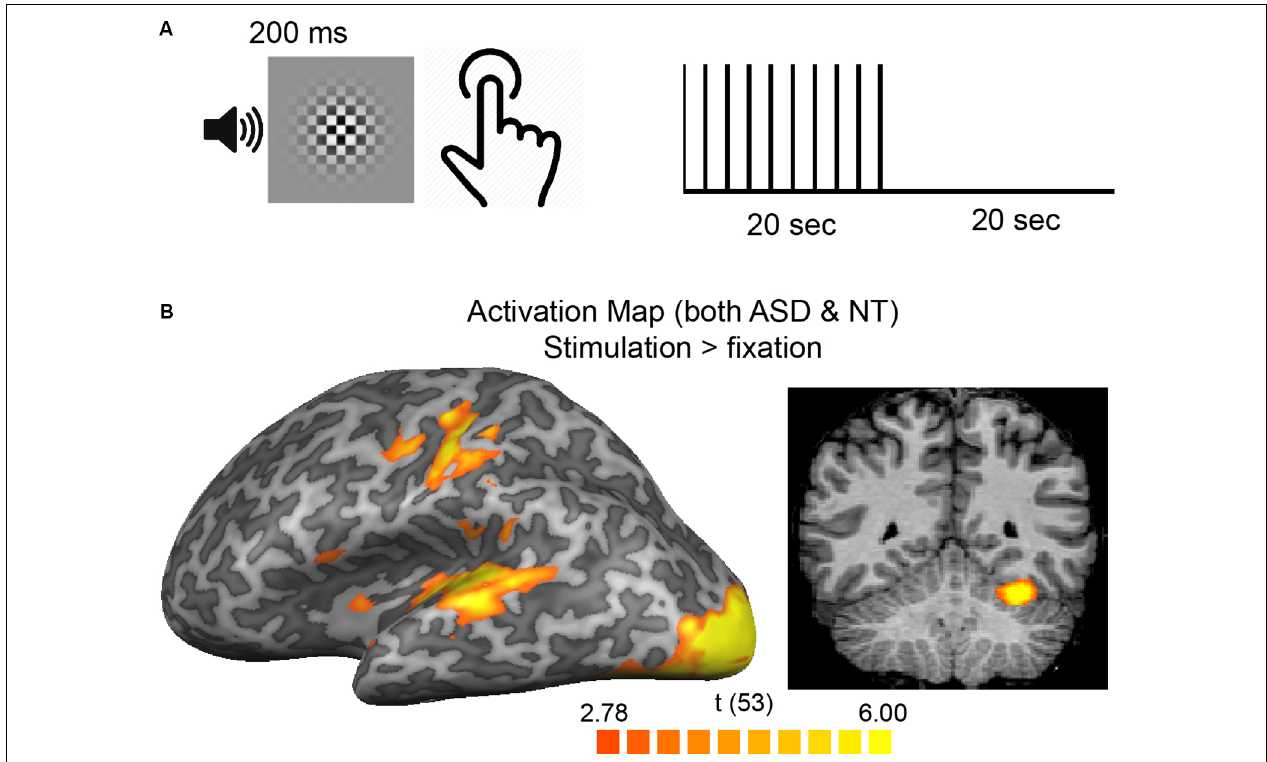
FIGURE 1 | (A) Participants pressed a button in response to a brief, simultaneous presentation of an auditory-visual stimulus. Stimuli were presented, on average, every 2-s in 20-s blocks separated by 20 s of rest. (B) A group average [both autism spectrum disorder (ASD) and neurotypical (NT)] activation map overlaid on the cortical surface of the left hemisphere (left) and a single coronal slice showing cortical and cerebellar regions with increased responses to a stimulus vs. rest